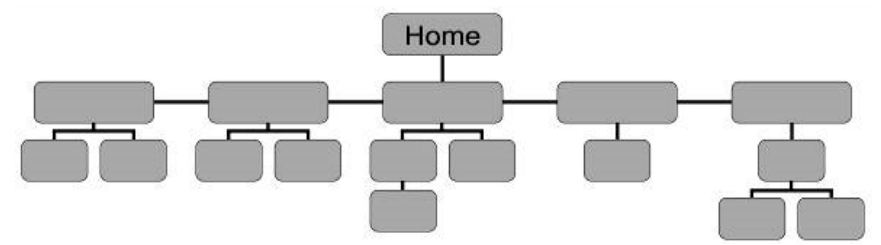
Figure 4. Overly broad information architecture makes it too many options to choose hardly.